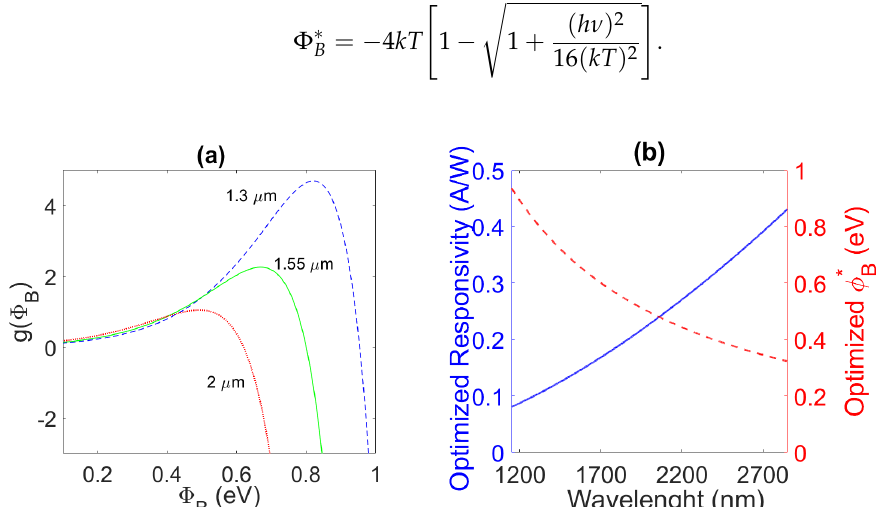
Figure 1. ( a ) Behavior of g ( Φ B ) at 300 K for three wavelengths: 1.3 µ m, 1.55 µ m, and 2 µ m; ( b ) opti- mized responsivity R (blue solid line) and optimized Schottky barrier height (SBH) Φ ∗ line) as a function of the